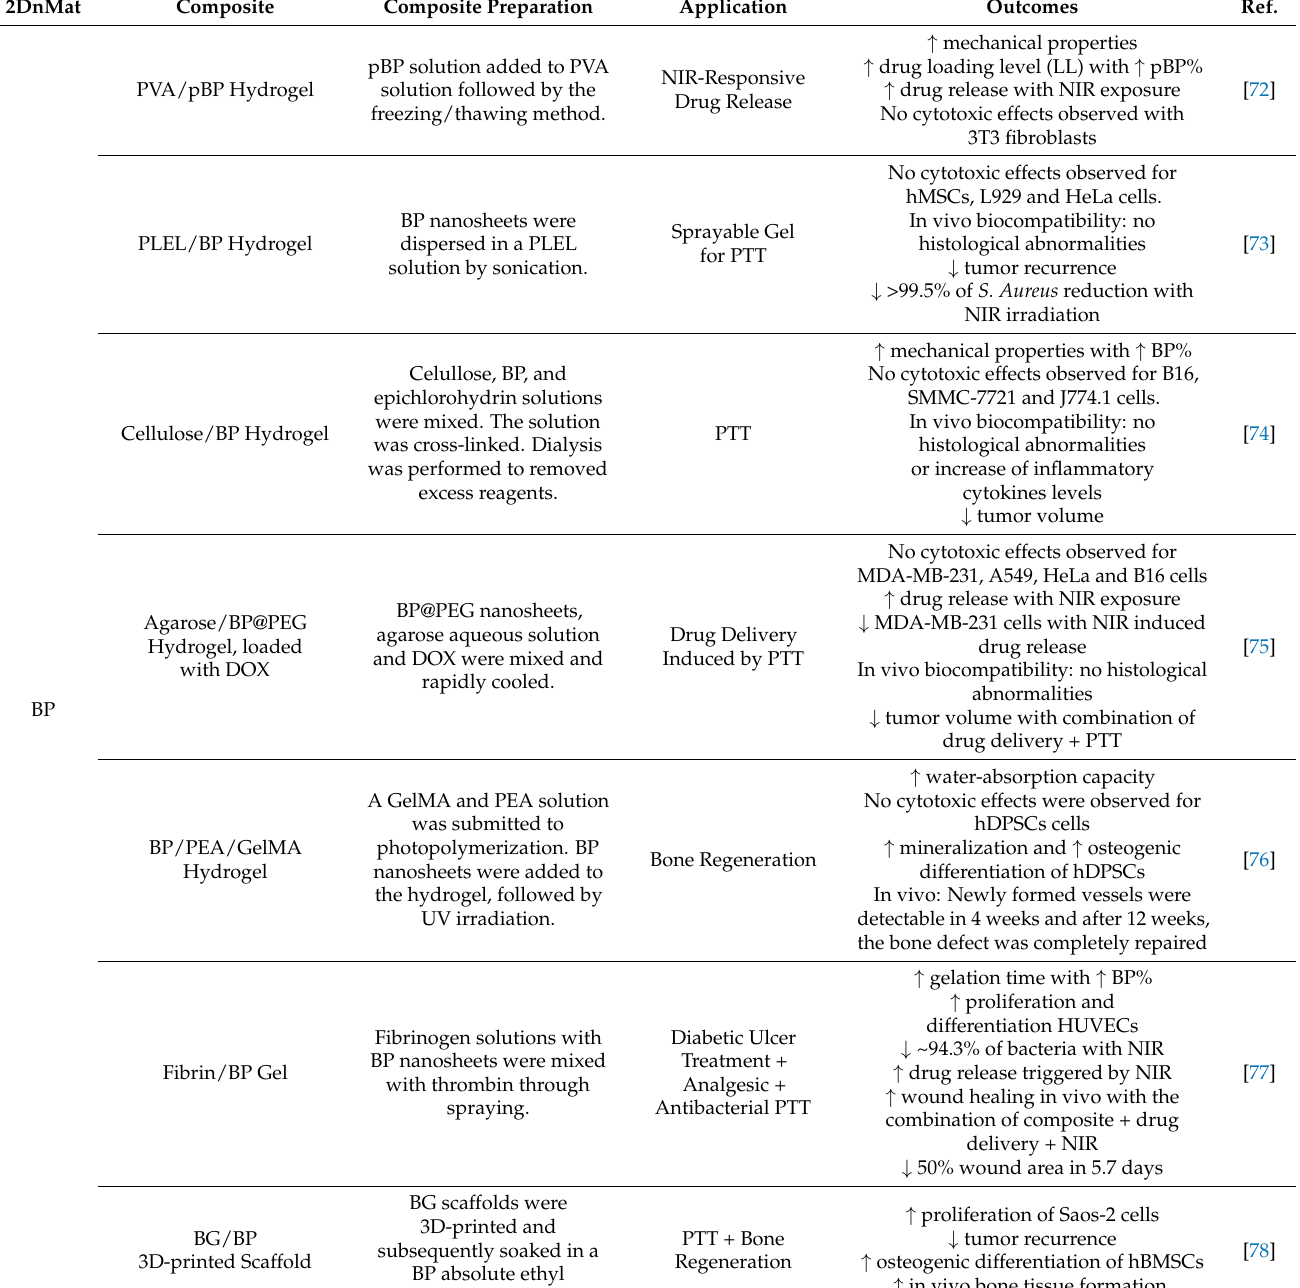
Table 1. Two-dimensional nanomaterials-based polymeric composites for biomedical applications, their specific functions, and general outcomes ( ↑ : increase; ↓ :